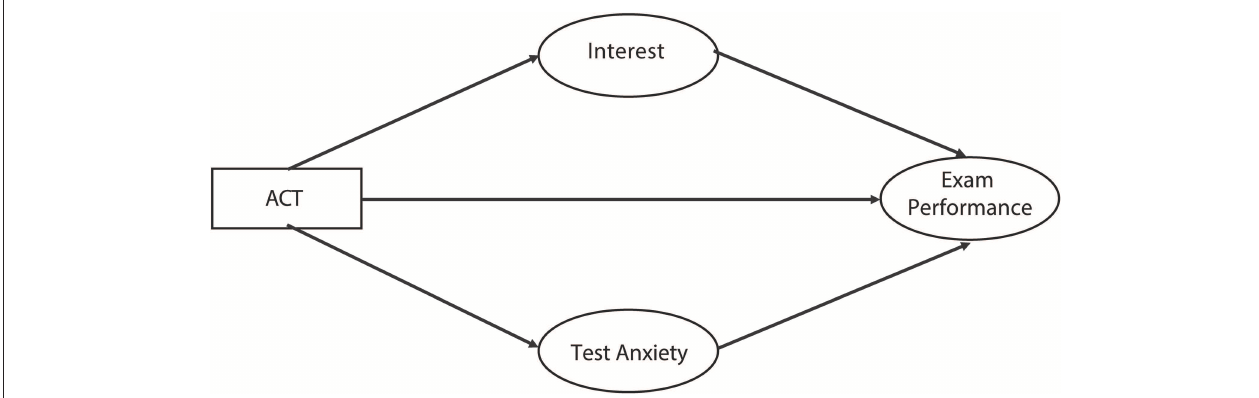
FIGURE 2 | Hypothesized model of the relationship among incoming preparation (ACT), social psychological factors (test anxiety, and interest in course content), and exam performance. We fit the structural equation model to data collected from men and women separately in the College of Biological Sciences (CBS) and the College of Science and Engineering (CSE), at both lower and upper division courses.